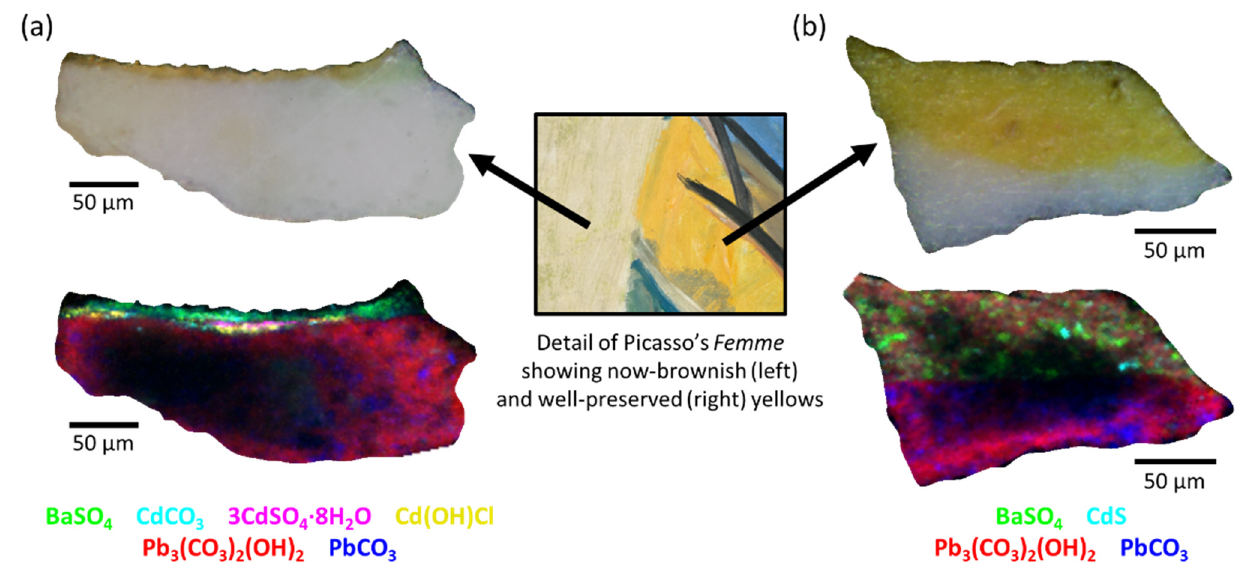
Figure 4. Detail of Picasso’s Femme containing both now-brownish (left) and vibrant (right) yellows. Visible image and SR-µXRPD distribution maps of crystalline phases identified in ( a ) now-brownish and ( b ) vibrant yellow micro-samples, extracted from representative areas of the painting. Samples were prepared as cross-sections embedded in resin. The colors of the different crystalline compounds identified are indicated in legend. The darker region in the center of the µXRPD maps is due to the poor transparency of the sample to X-rays (measurements acquired in transmission mode).